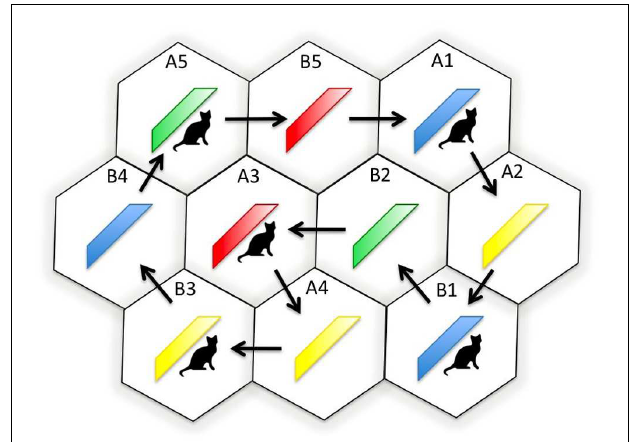
FIGURE 2 | Schematic diagram showing the dance floor hexagons, the initial positions, and group membership of the dancers (A1, A2, B1, B2, and so on.), the sash color worn by each dancer (blue, yellow, green, or red), and whether or not the dancer wore a cat symbol.